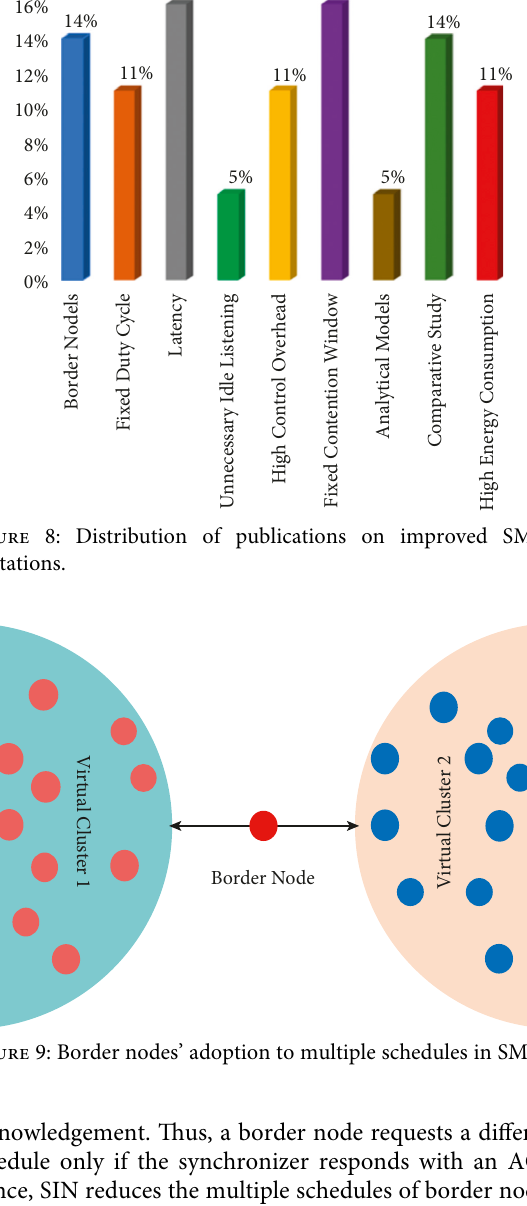
Figure 9: Border nodes’ adoption to multiple schedules in